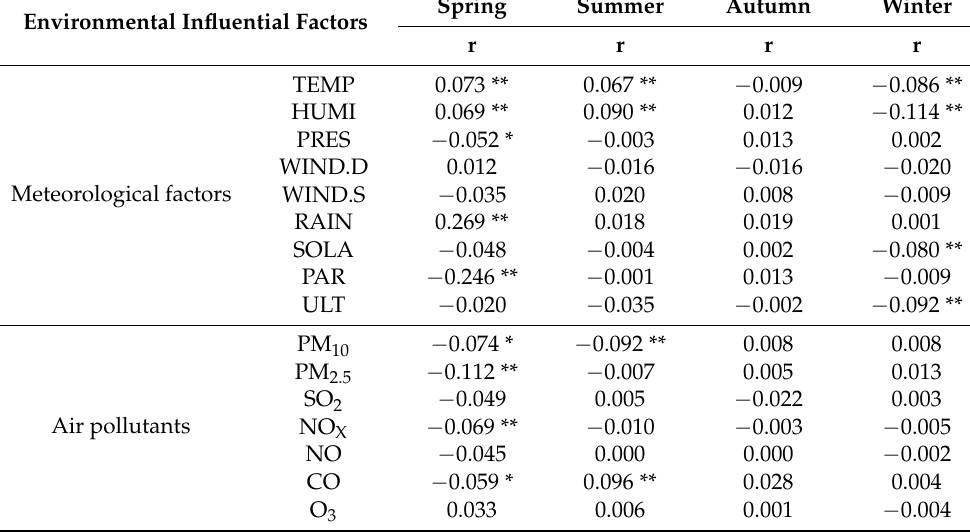
Table 1. Pearson correlation between NAIC and environmental influencing factors. (TEMP represents temperature, HUMI represents humidity, PRES represents pressure, WIND.D represents wind direction, WIND.S represents wind speed, RAIN represents rainfall, SOLA represents full radiation, PAR represents photosynthetically active radiation, ULT represents ultraviolet radiation). Spring Summer Autumn Winter Environmental Influential Factors